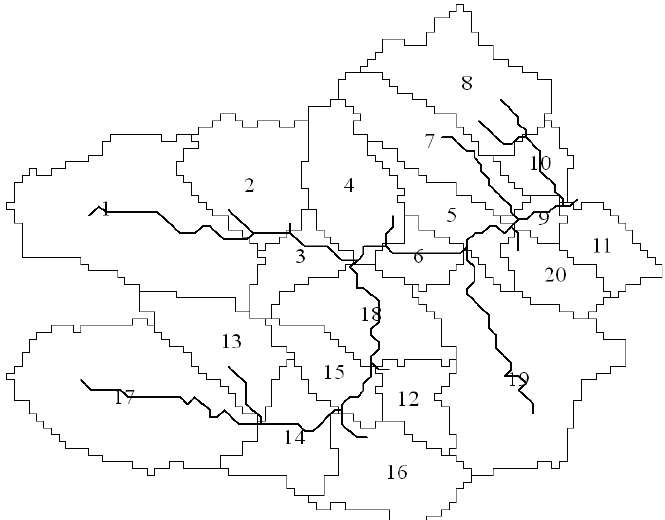
Fig. 1 Drainage network and delineated sub-basins of the Dongwan